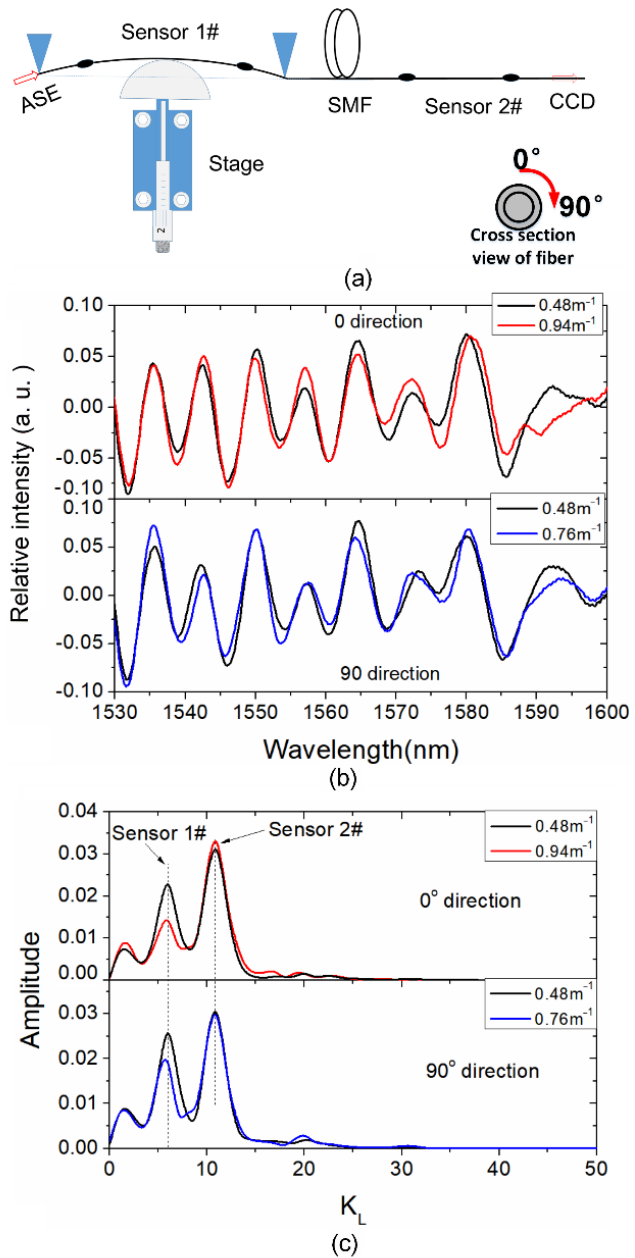
Figure 5. ( a ) Schematic of curvature test for the two cascaded WWFT-based interferometers; ( b ) Spectra and ( c ) Spectra after FFT for the WWFT-based interferometer 1# and 2# at 0° direction and 90° direction, respectively.